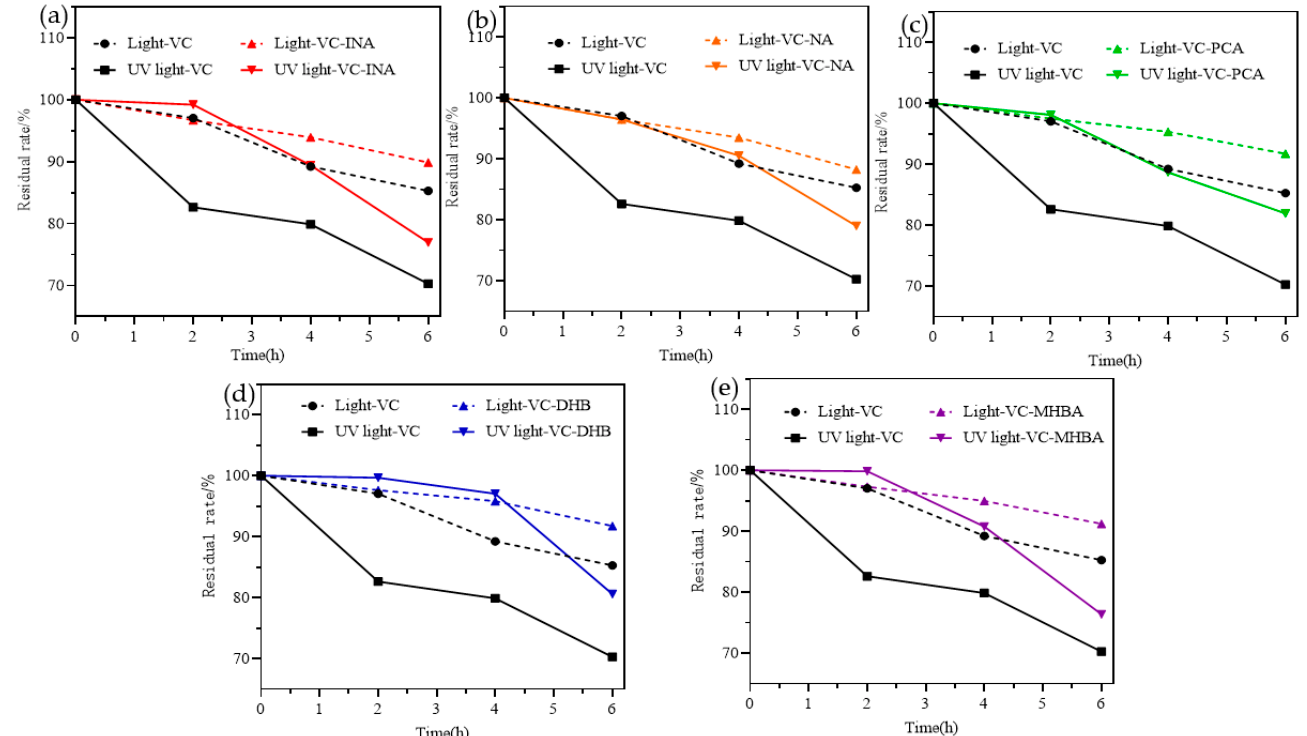
Figure 6. Photostability of VC co-crystals (( a ): VC-INA; ( b ): VC-PCA; ( c ): VC-NA; ( d ): VC-DHB; ( e ): VC-MHBA).